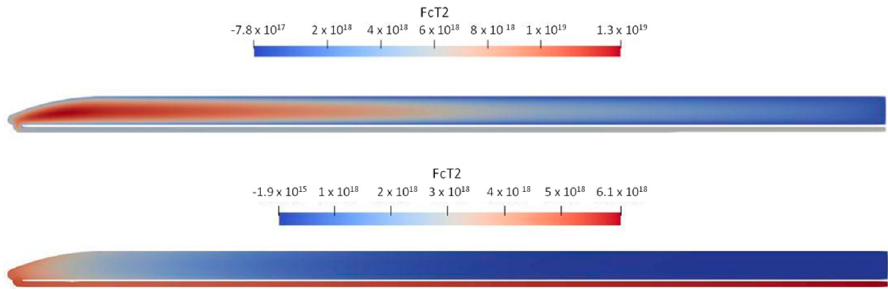
Figure 9. T 2 in breeder purge gas at 20,000 s problem time for T 2 vs. HT release from pebbles.